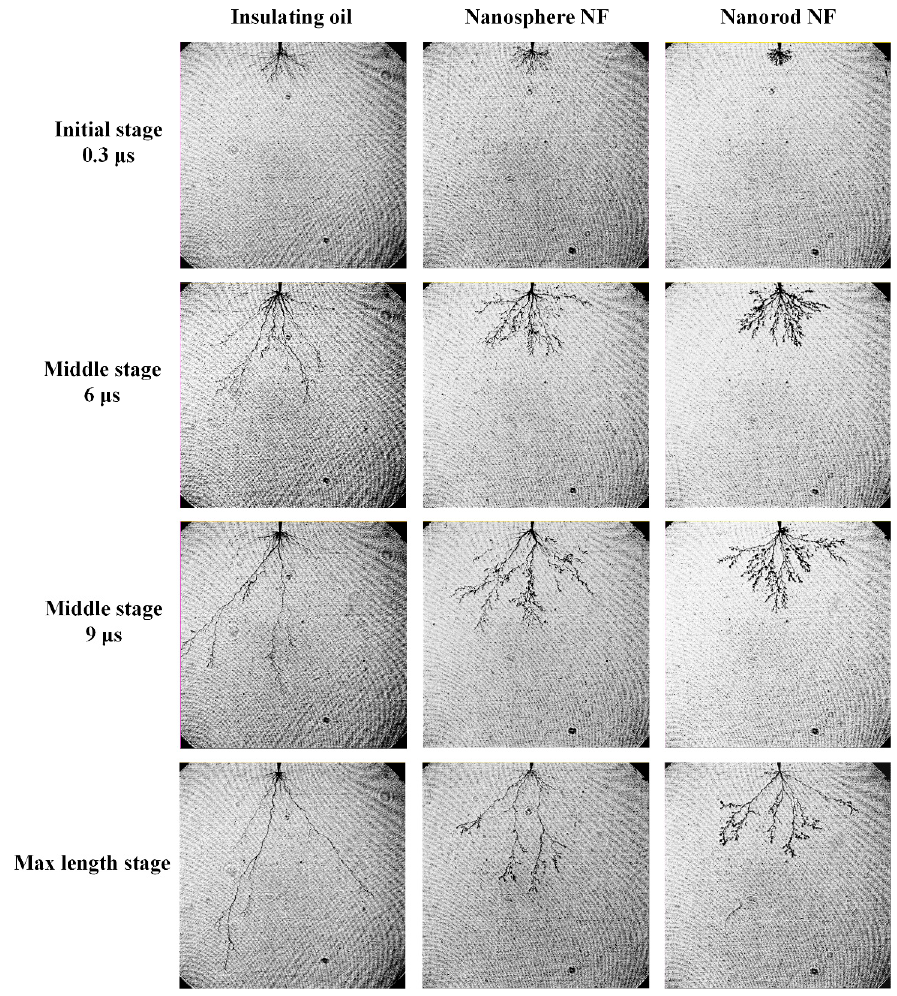
Figure 5. Pre-breakdown streamer propagation images for insulating oil, nanofluid with nanospheres and nanorods.